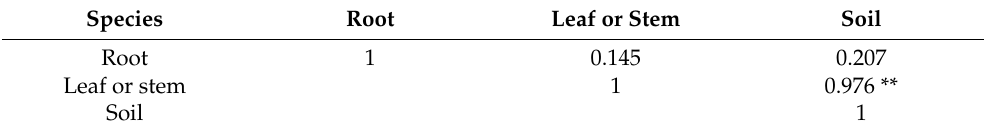
Table 5. Pearson correlation analysis between each part of crops and soil Cr content.